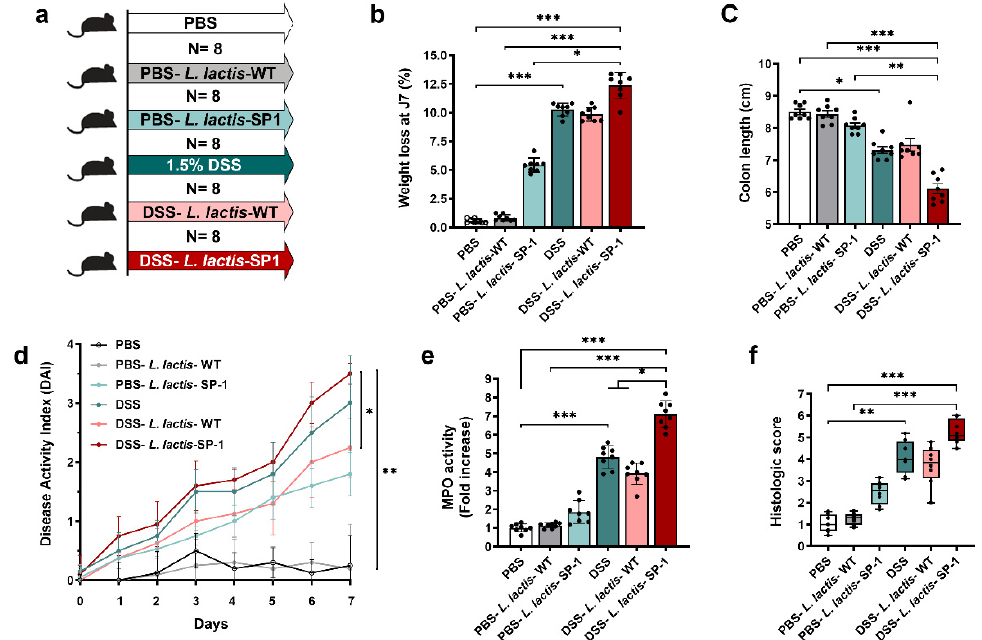
Figure 4. Administration of L. lactis secreting SP-1 influences colitis. ( a ) C57BL/6 mice were provided with water or 1.5% DSS-containing water for 7 days (N = 8 in each group). Mice were orally administered with PBS, PBS- L. lactis- WT, PBS- L. lactis- SP-1, DSS alone, DSS- L. lactis -WT or DSS- L. lactis- SP-1 (5 × 10 9 CFU L. lactis -WT or SP-1-expressing L. lactis were evaluated / day). ( b ) Body weight loss for each group. ( c–e ) Mice were euthanized (day 8), and ( c ) colon length, ( d ) disease activity index, and ( e ) colonic MPO activity were measured. ( f ) Histological scores were determined. Data are presented as mean ± SEM from a representative experiment (N = 8 biologically independent animals). Analyzed by Kruskal–Wallis followed by the multi-comparison Dunn’s test. * p < 0.05; ** p < 0.01 and *** p < 0.001 .